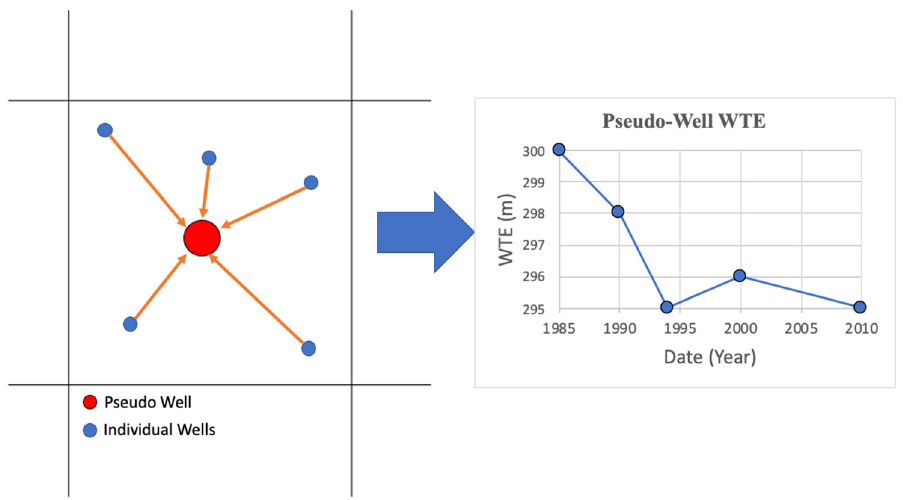
Figure 4. A synthetic time series formed by aggregating WTE values from wells in the vicinity of a